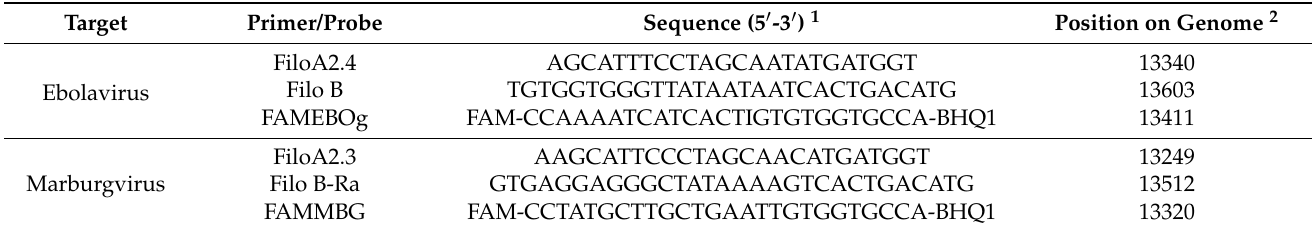
Table 2. Primer and probes used for the hydrolysis probe-based assay targeting the RNA-dependent RNA polymerase gene of Ebola- and Marburgvirus [30].